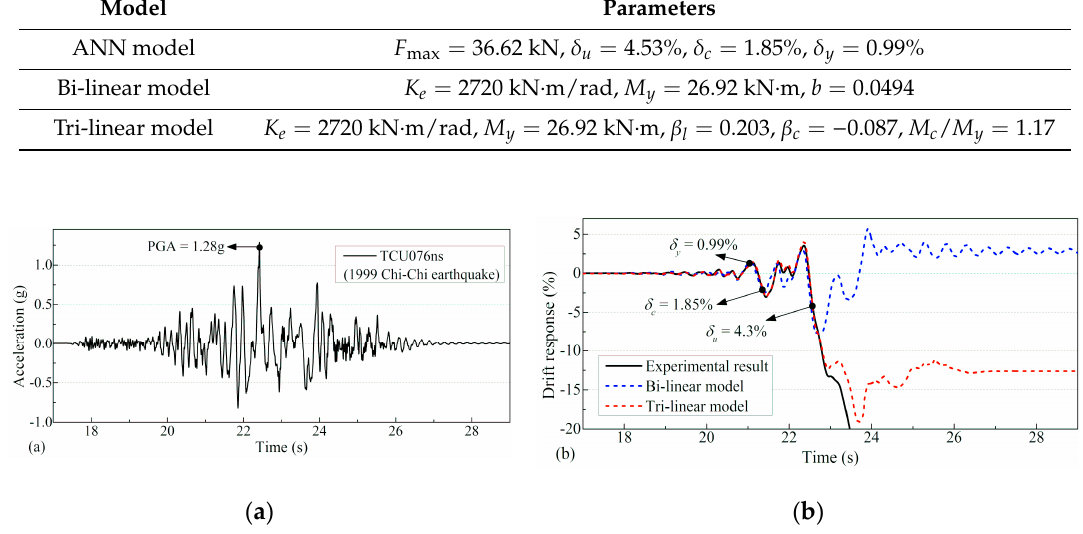
Ground motion record; and ( b ) drift response. ( a )